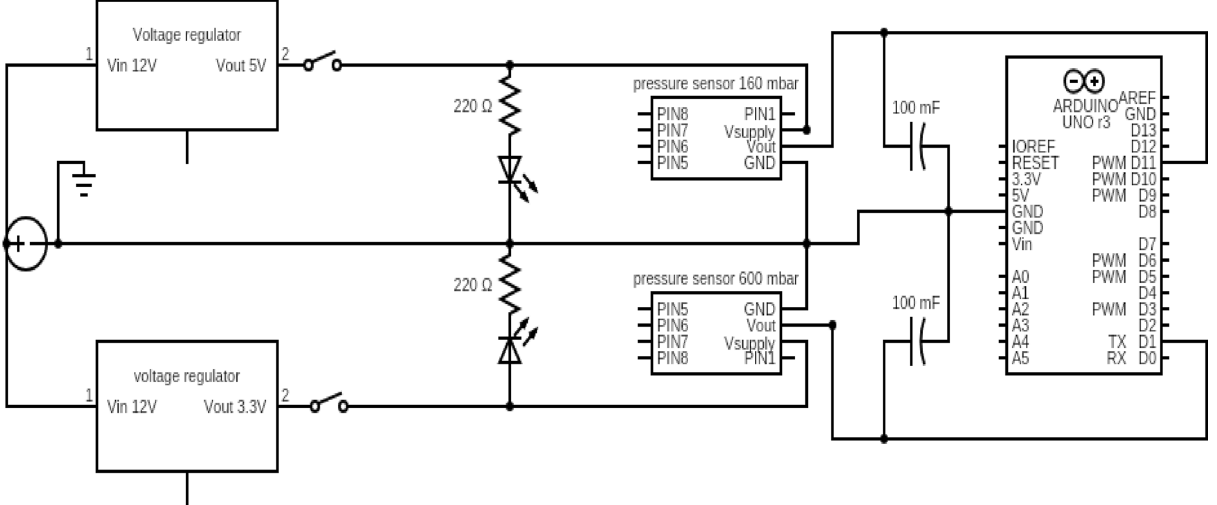
Figure 14. Scheme of the electronic circuit for the pressure sensors